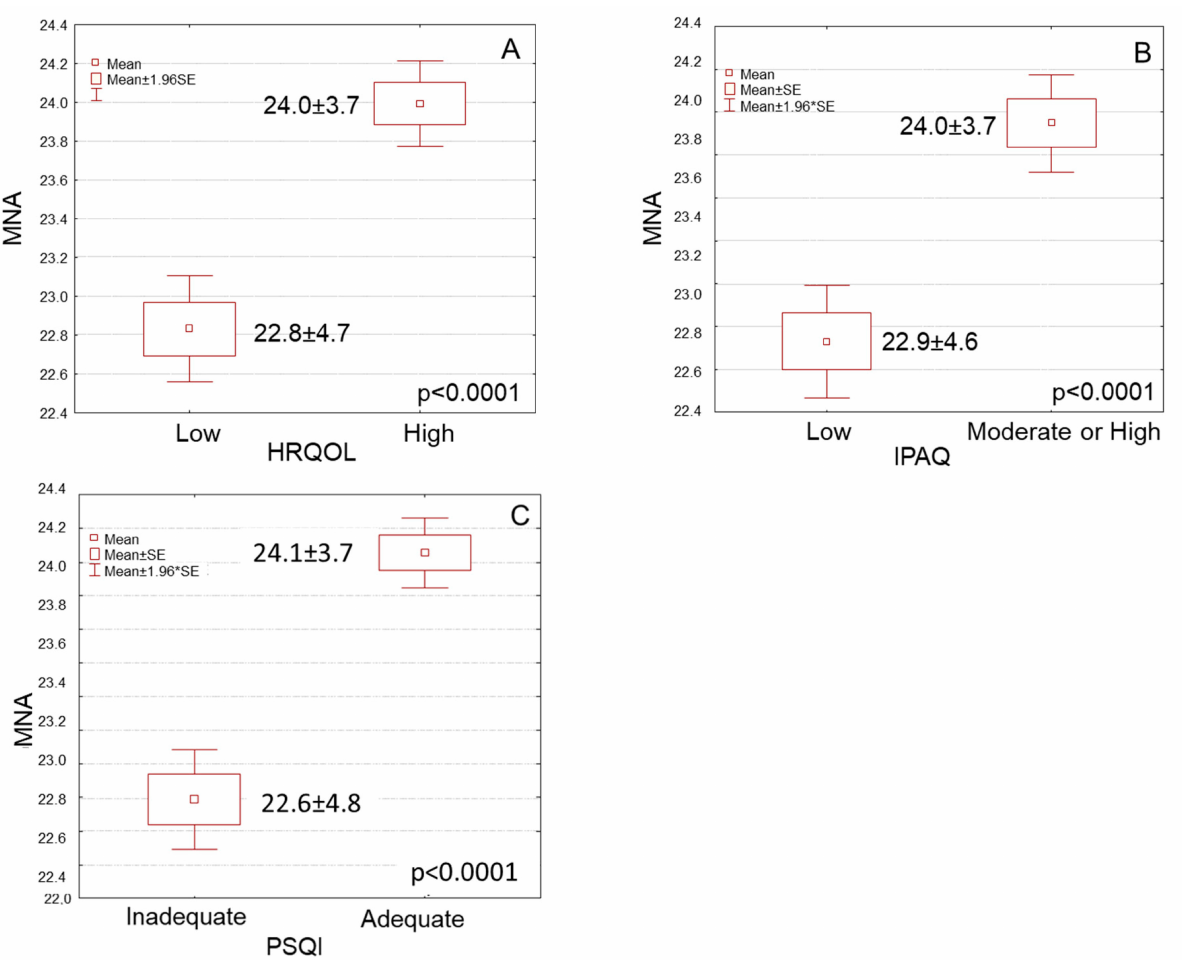
Figure 1. Box and whisker plots for nutritional status according to MNA of elderly participants in association with their ( A ) HRQOL, ( B ) IPAQ and ( C )